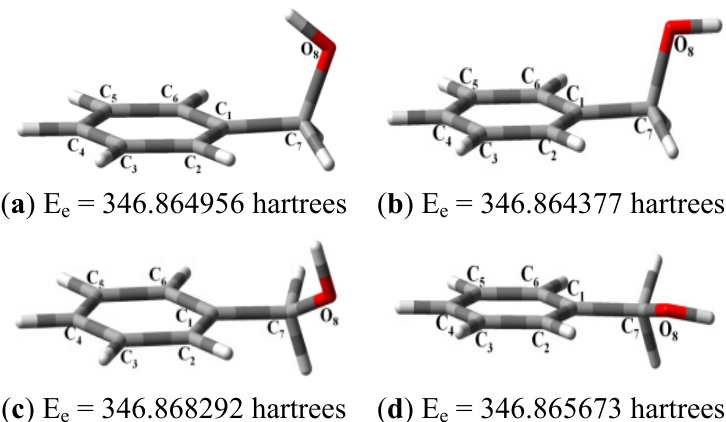
Figure 1. Conformers of benzyl